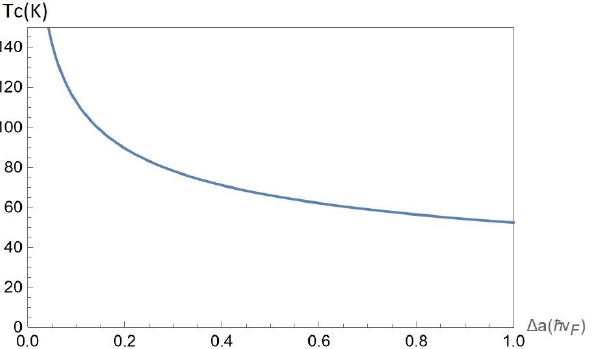
Figure 12. The mean-field phase transition critical temperature T c ( n A , n B , α , ∆ , D ) versus the gap ∆ for chosen parameter α = 0.6, interlayer separations D = 25 nm at the fixed concentrations n A = 50 × 10 11 cm − 2 and n B = 50 × 10 11 cm − 2 of A and B excitons,